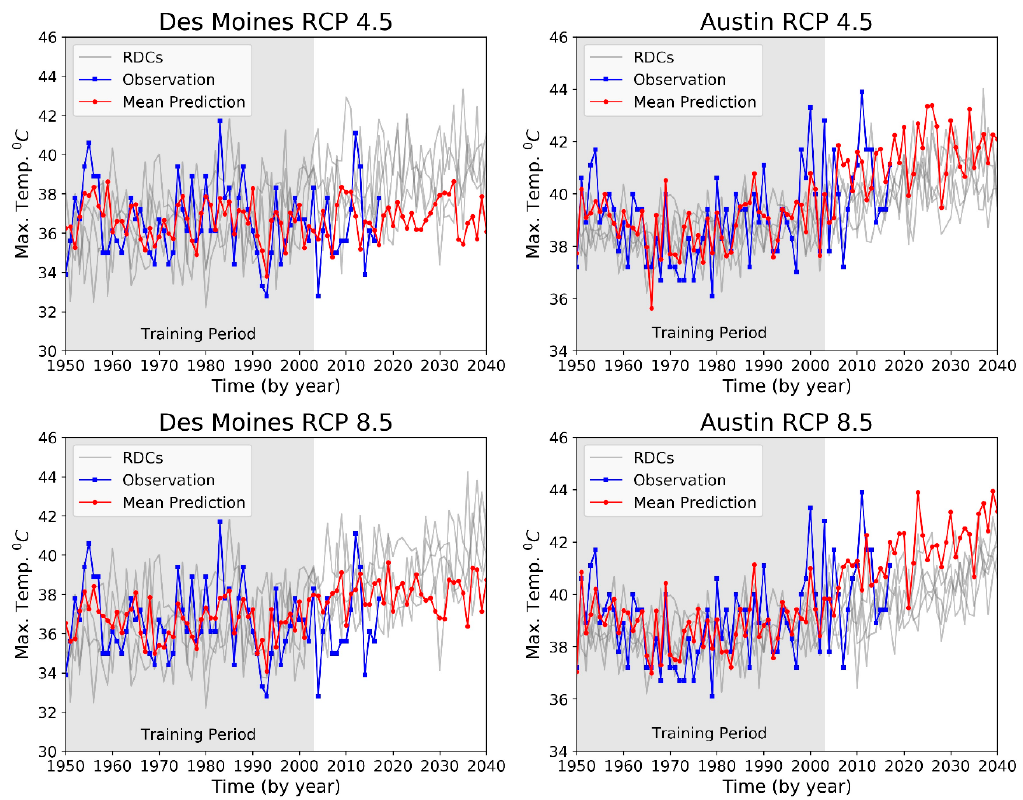
Figure 5. Annual maximum temperature observations (blue lines with square markers), predictions from the reduced-order EMOS model (red lines with circle markers) and RDC projections (gray lines) for Des Moines and Austin.